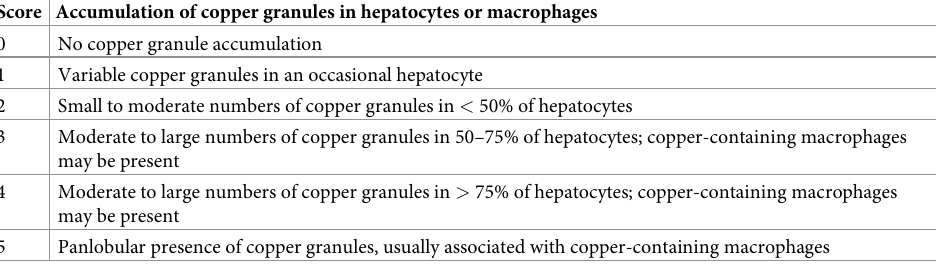
Table 1. A copper scoring system for qualitative copper assessment modified from a scoring system used for liver biopsy specimens in dogs [16]. Score Accumulation of copper granules in hepatocytes or